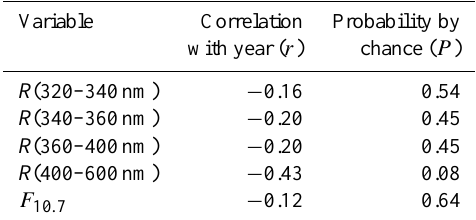
Table 2. Correlation of mean irradiance ratios with year (based on 17 Solstice Periods, 1992 through